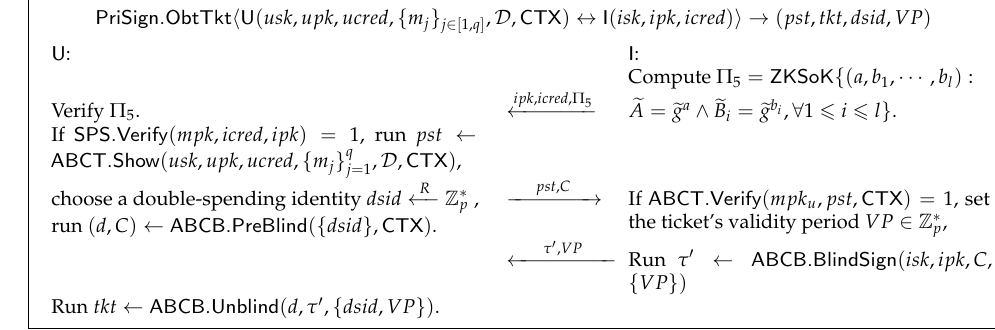
Figure 10. Obtain Tickets algorithm.